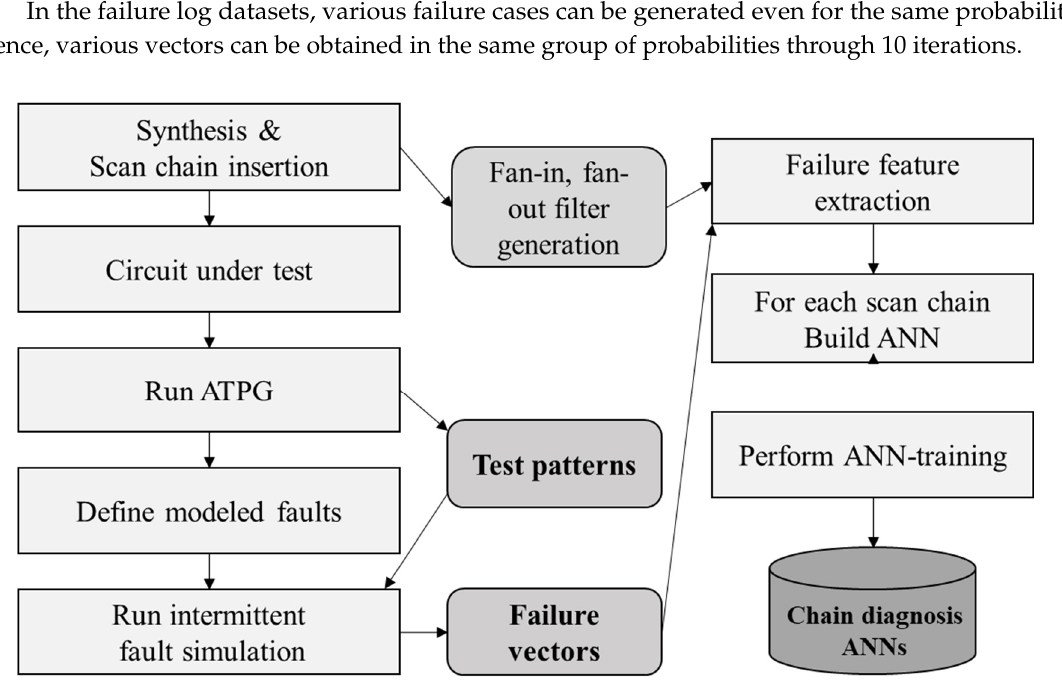
Figure 4. Flowchart of the proposed methodology. ATPG: automatic test pattern generation; ANN: artificial neural networks.